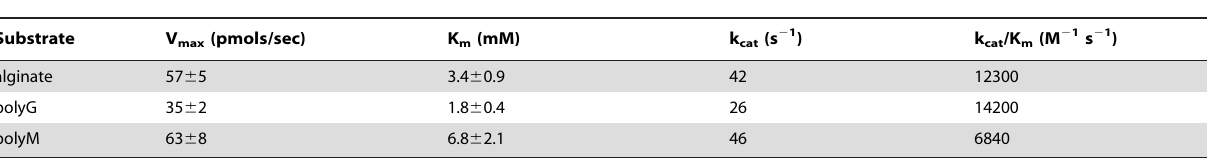
Table 2. Kinetics of